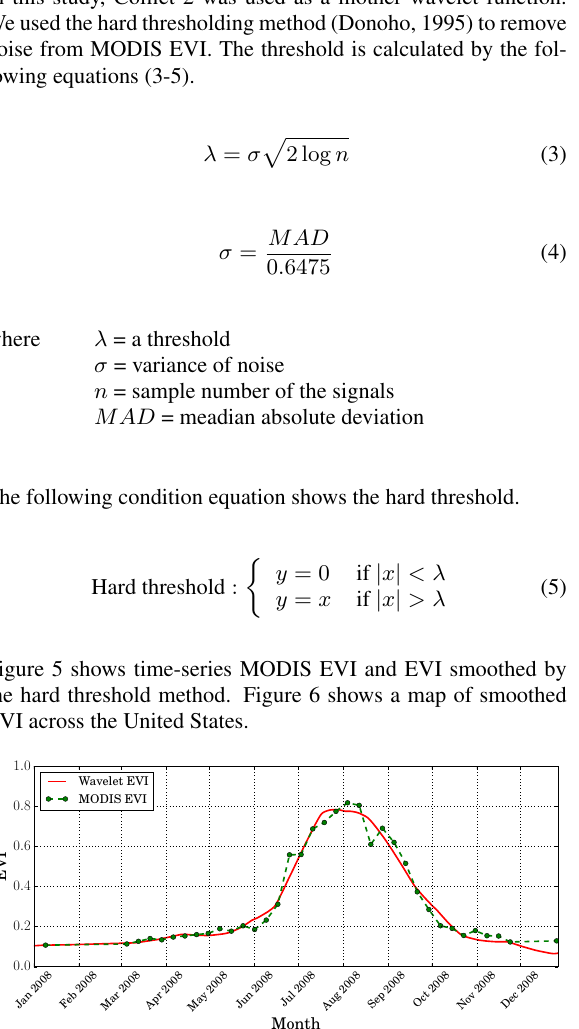
Figure 5: MODIS EVI and EVI smoothed by the wavelet trans- form 2.2.2 Normalizing the input data Meteorological data from Daymet and MODIS EVI were input data for the corn yield esti- mation model in this study, and those data have different ranges.